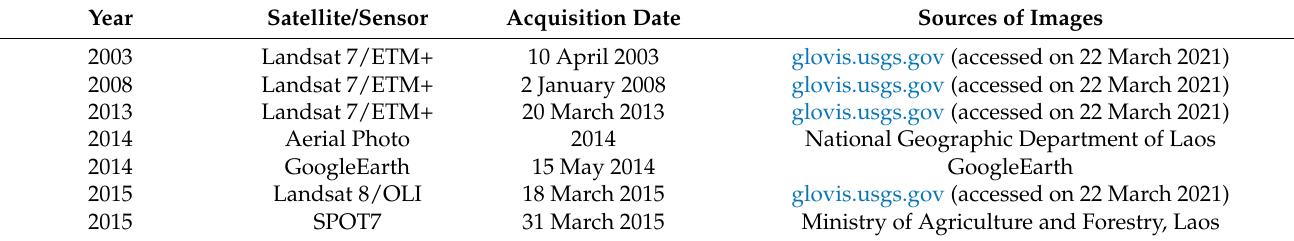
Table A1. List of remote sensing data used.